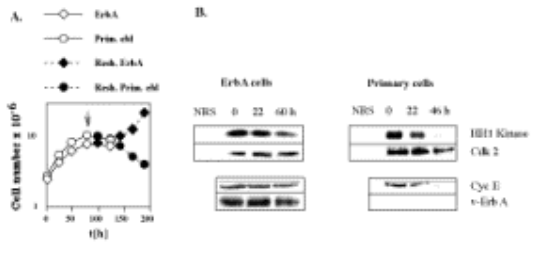
Fig. 1. v-erbA expression in growth factor deprived primary erythroblasts delays apoptosis and retains Cdk2 associated kinase